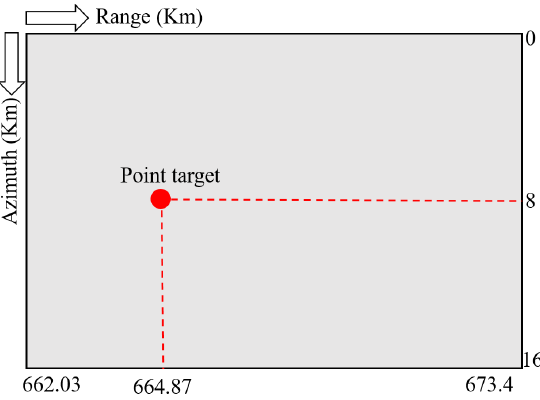
Figure 5. The location of a point target at the non-ambiguous imaging